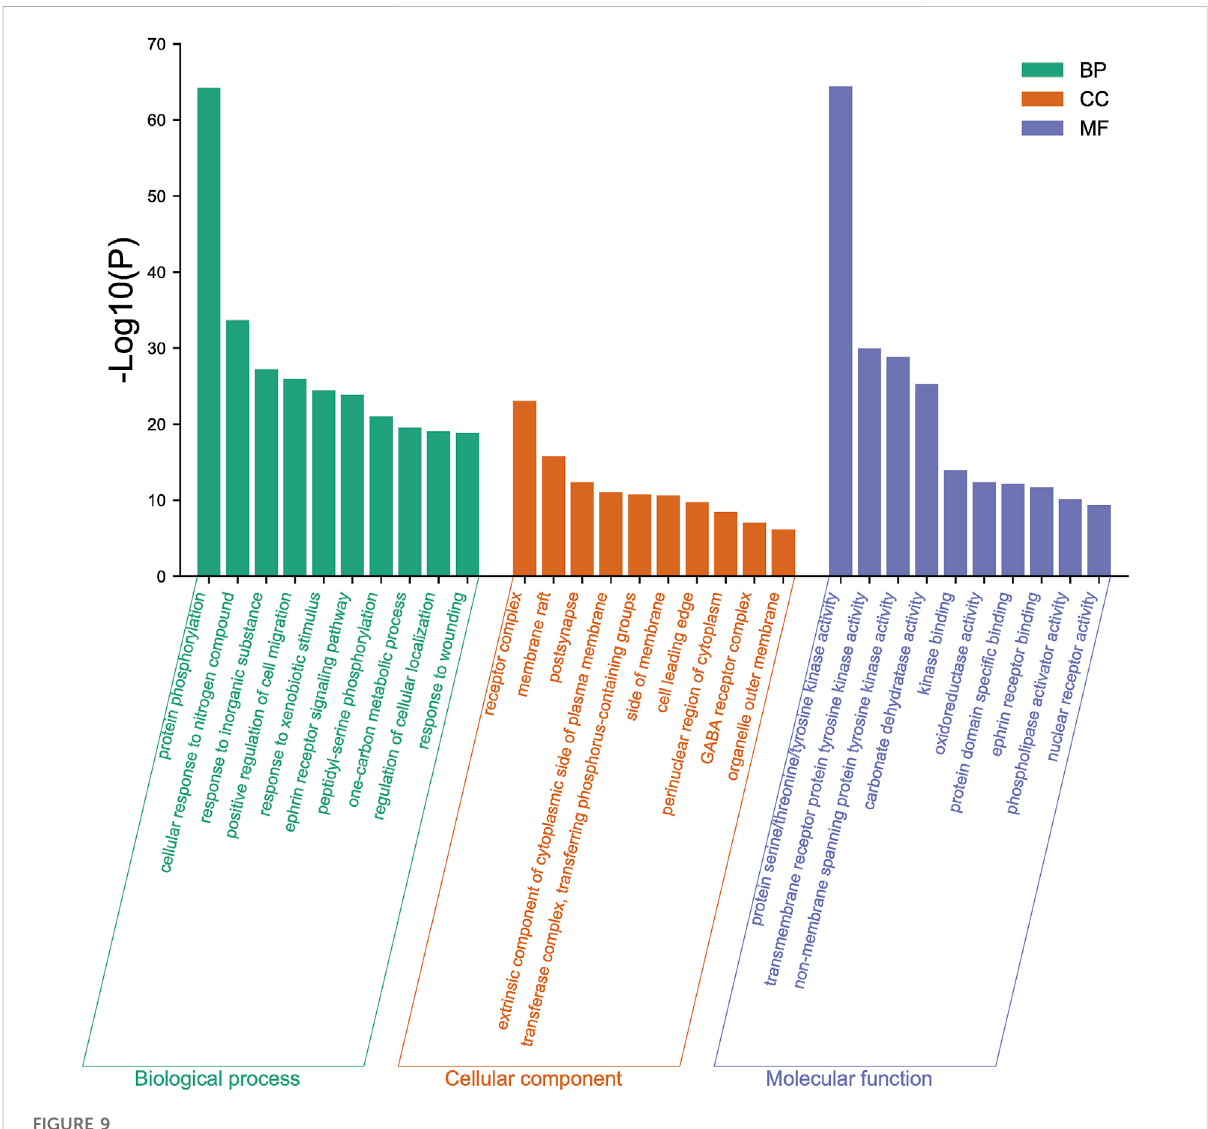
FIGURE 9 GO enrichment analysis of mulberroside A